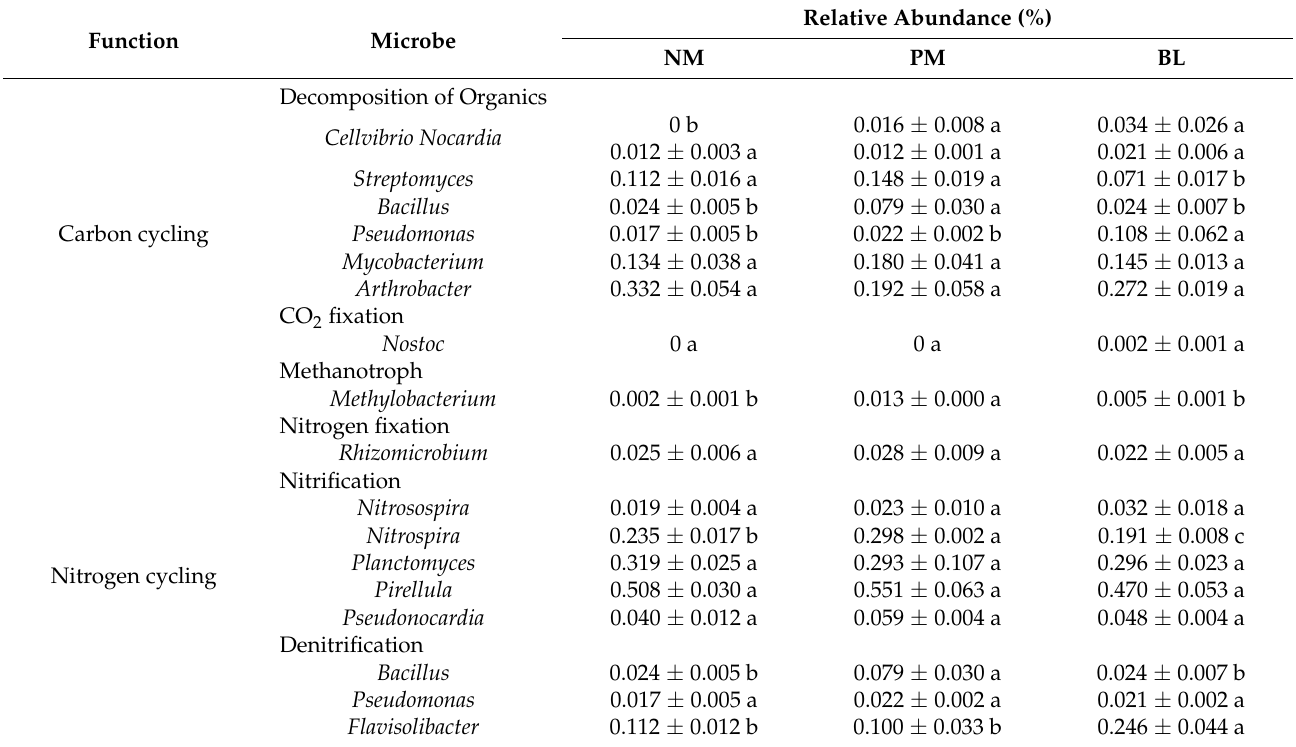
Relative Abundance (%)